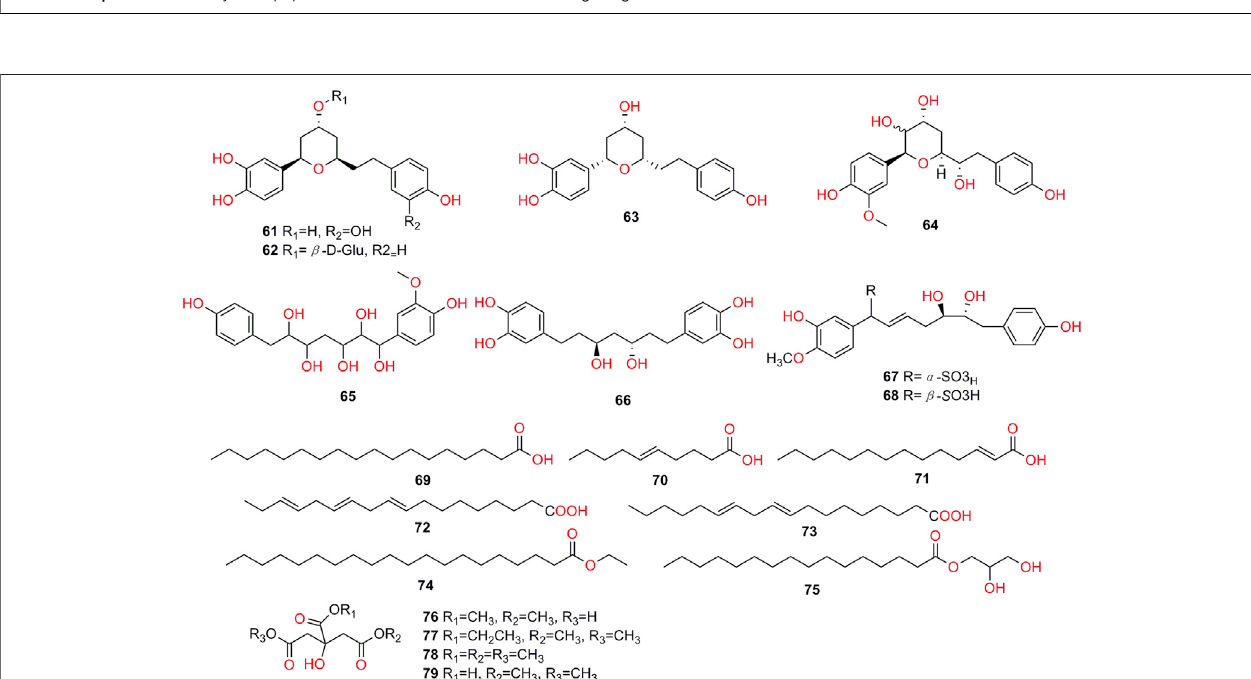
FIGURE 6 | Structures of diarylheptanoids, fatty acids and esters isolated from K. galanga .